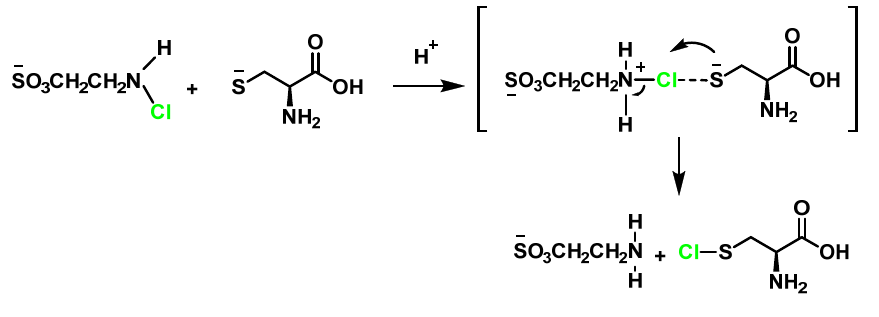
Figure 30. Formation of